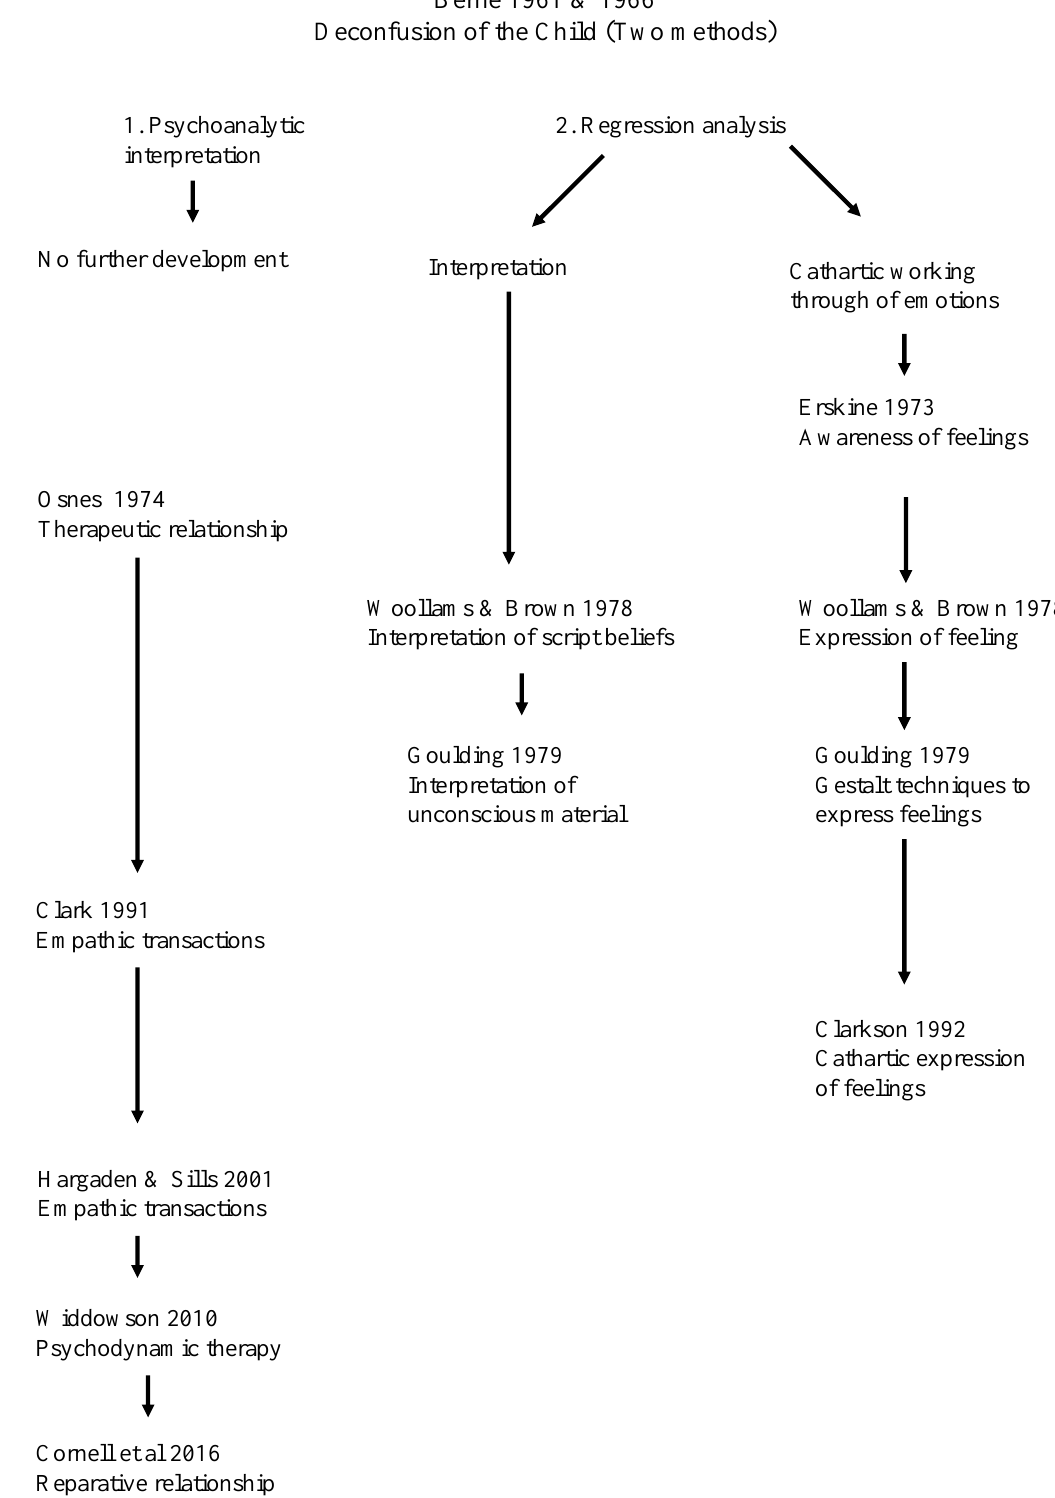
Figure 1: Deconfusion of Child: Development of